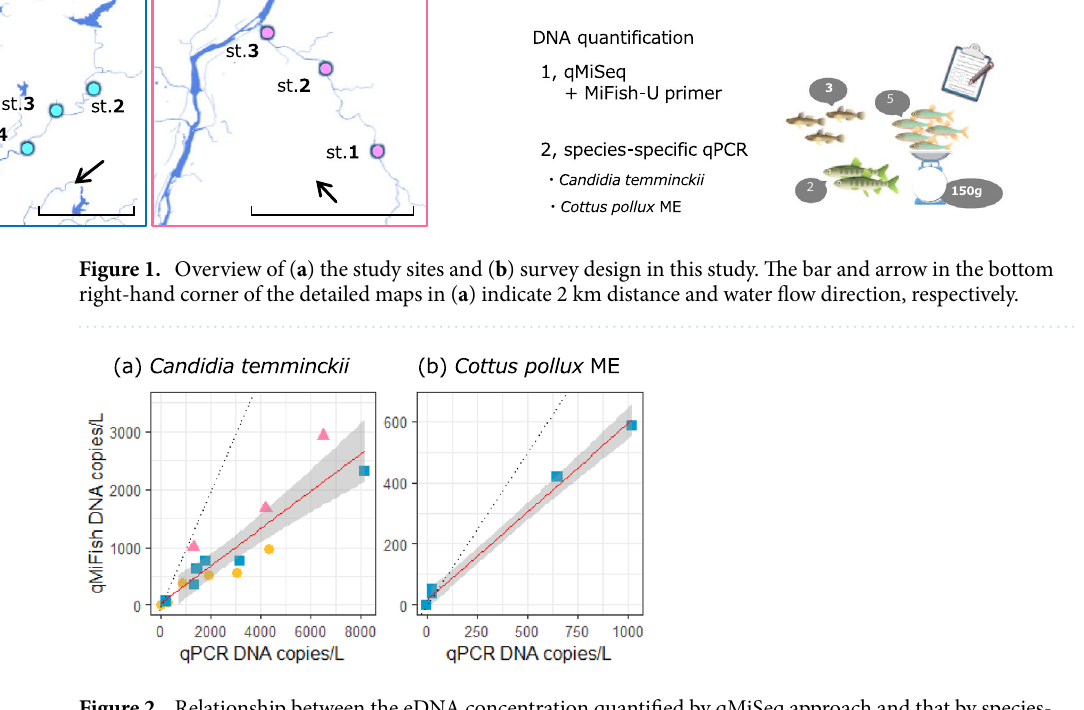
Figure 2. Relationship between the eDNA concentration quantified by qMiSeq approach and that by species- specific qPCR for ( a ) C. temminckii and ( b ) C. pollux ME. Yellow circles (FK), pink triangles (HS) and blue squares (IN) indicate each study river, respectively. Solid and dashed lines indicate linear regression lines (all regression lines are significant, P < 0.001) and 1:1 line, respectively. The shaded area around each linear regression lines corresponds to the 95% confidence